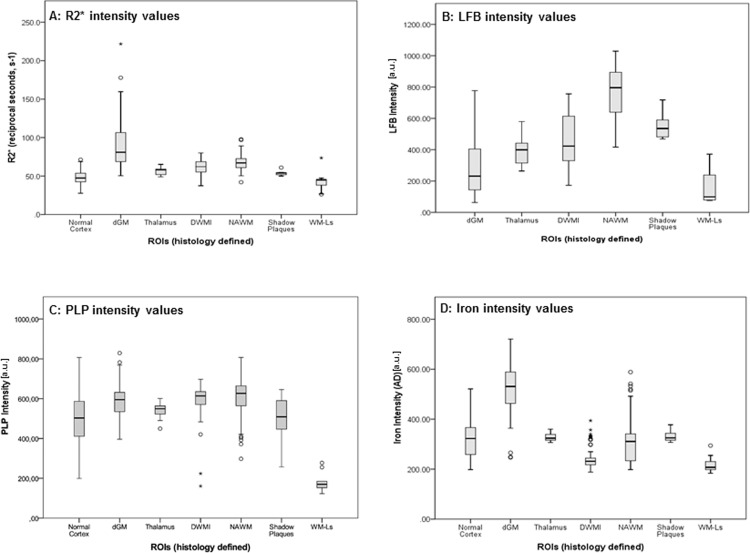
Differences in R2* values (A), LFB (myelin, B), PLP (myelin, C) and iron intensities (D) among different ROIs. Boxes represent the 25th-75th percentile (interquartile range, IQR) and the black line inside the boxes represents the median value. The whiskers delineate all values within 1.5x IQR away from the respective lower or upper quartile, while circles (10th-90th) and stars (5th-95th) represent outliers. In the fig: dGM = deep gray matter, DWMI = diffuse white matter injury, NAWM = normal white matter, WM-Ls = white matter lesions (central core).